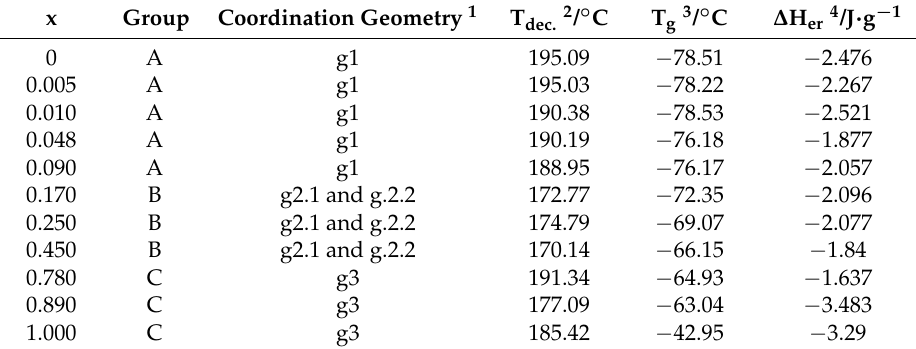
Table 3. Coordination geometries and thermal results of Gly and GlyLi x electrolytes.